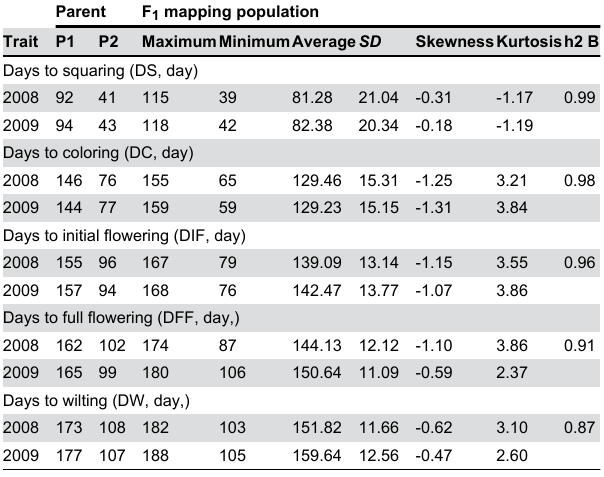
Table 1. Descriptive statistics and broad sense heritability of flowering time in chrysanthemum, based on performance of the F mapping population bred from the cross 1